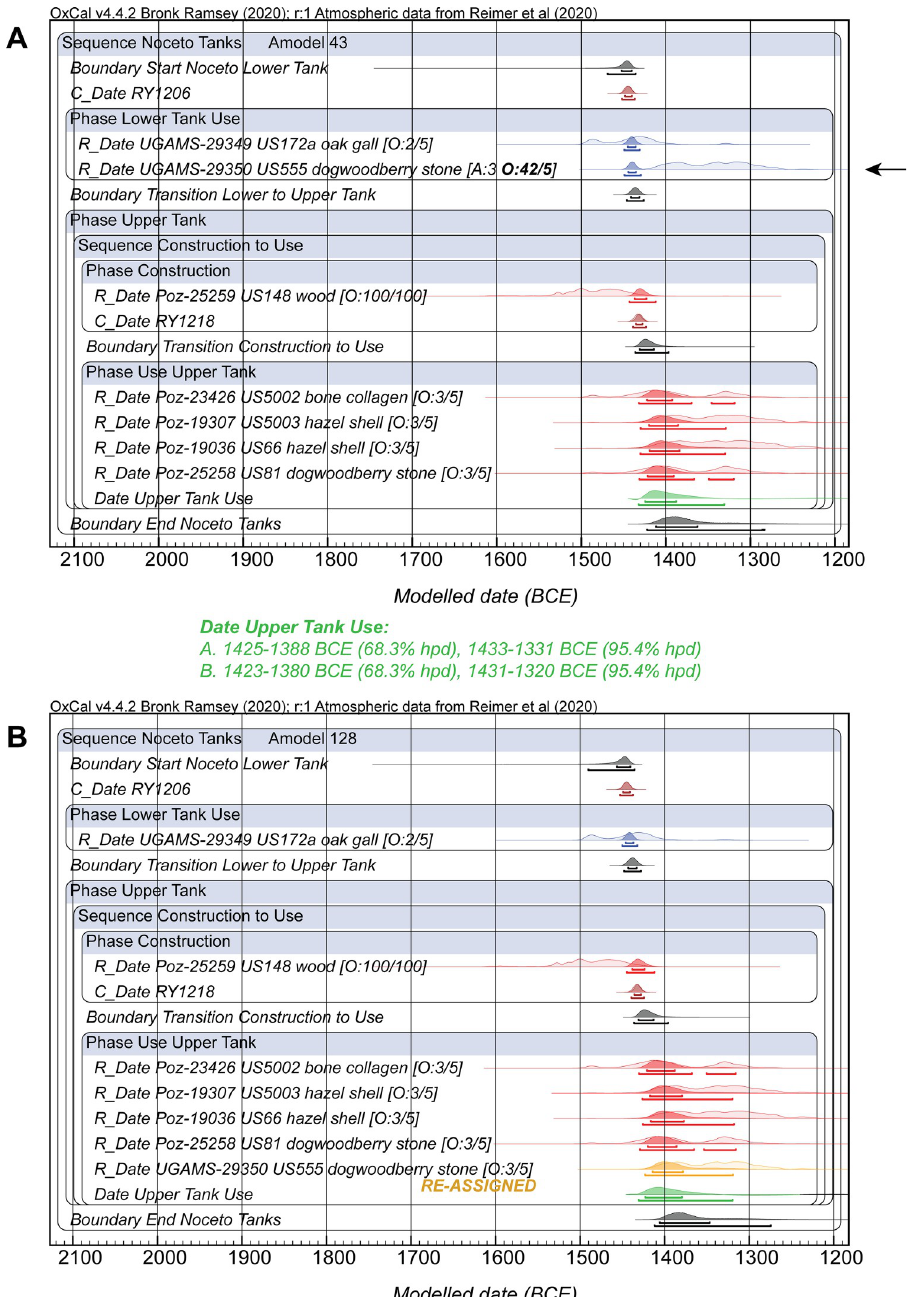
Fig 17. Bayesian chronological model combining (i) the wiggle-match date for lower tank felling-construction, (ii) 14 C dates on short-lived sample(s) associated with the use of the Noceto lower tank, (ii) a 14 C on wood of the upper tank and the wiggle-match date for the upper tank felling-construction, and then (iii) 14 C dates on short- lived samples associated with the use of the upper tank. The OxCal General Outlier model is applied to the 14 C dates on short(er)-lived samples, the OxCal Charcoal Outlier model is applied to the date on a wood sample (unknown what tree rings dated and we assume some in-built age likely) [27]. A. All data with UGAMS-29350 a clear outlier (too recent, indicated by arrow)–perhaps a sample that should belong with the upper tank use period? B. The model re-run after re-assigning UGAMS-29350 to the upper tank period of use. The results are very similar. Data from OxCal [26, 27] version 4.4.2 using IntCal20 [29] with curve resolution set at 1 year. The lines under each distribution indicate the modelled 68.3% and 95.4% hpd ranges